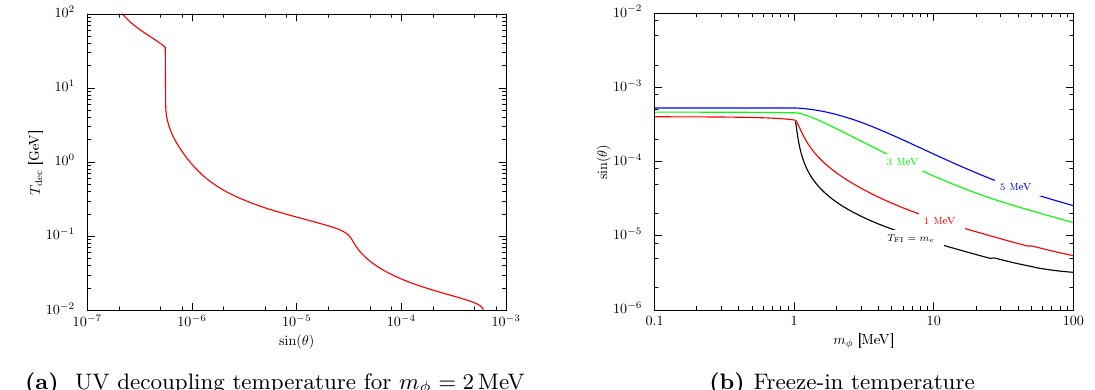
Figure 11. (a): The UV decoupling temperature of φ from the SM sector as a function of the mixing angle. The decoupling temperature hardly depends on the dark scalar mass as far as T dec & m φ . (b): The contour plot of the freeze-in temperature on the ( m φ , sin( θ )) plane. For the definition of the freeze-in temperature, see the